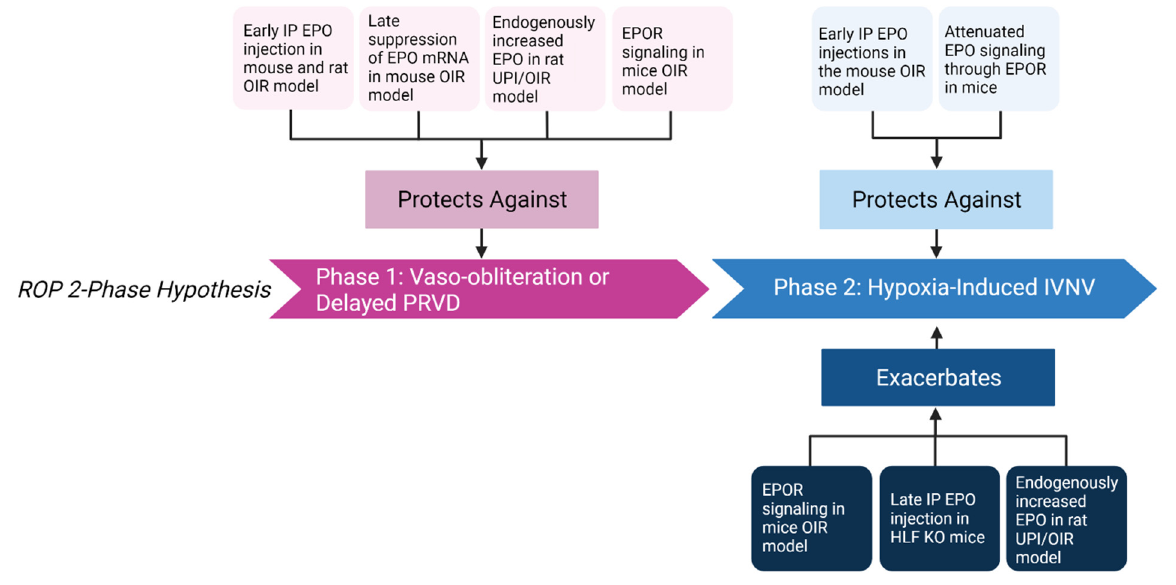
Figure 3. Effect of EPO and EPOR signaling on Phase 1 and Phase 2 ROP. Early treatment indicates that treatment was given prior to or at the start of Phase 1 ROP or hyperoxia-induced vascular loss; late treatment indicates that treatment was given at the end of or after Phase 1. Studies show that early exogenous intraperitoneal (IP) erythropoietin (EPO), late EPO suppression, endogenously increased EPO from uteroplacental insufficiency (UPI), and erythropoietin receptor (EPOR signaling) protect against vaso-obliteration or delayed PRVD in oxygen-induced retinopathy (OIR) animal models. Early exogenous EPO and attenuated EPO signaling through EPOR protects against Phase 2 hypoxia-induced intravitreal neovascularization (IVNV); however, late EPO injection in HIF-1 α -like factor (HLF) knock out (KO) mice endogenously increased EPO from uteroplacental insufficiency (UPI), and EPOR signaling has been shown to exacerbate IVNV in animal OIR models. Created with Biorender.com.